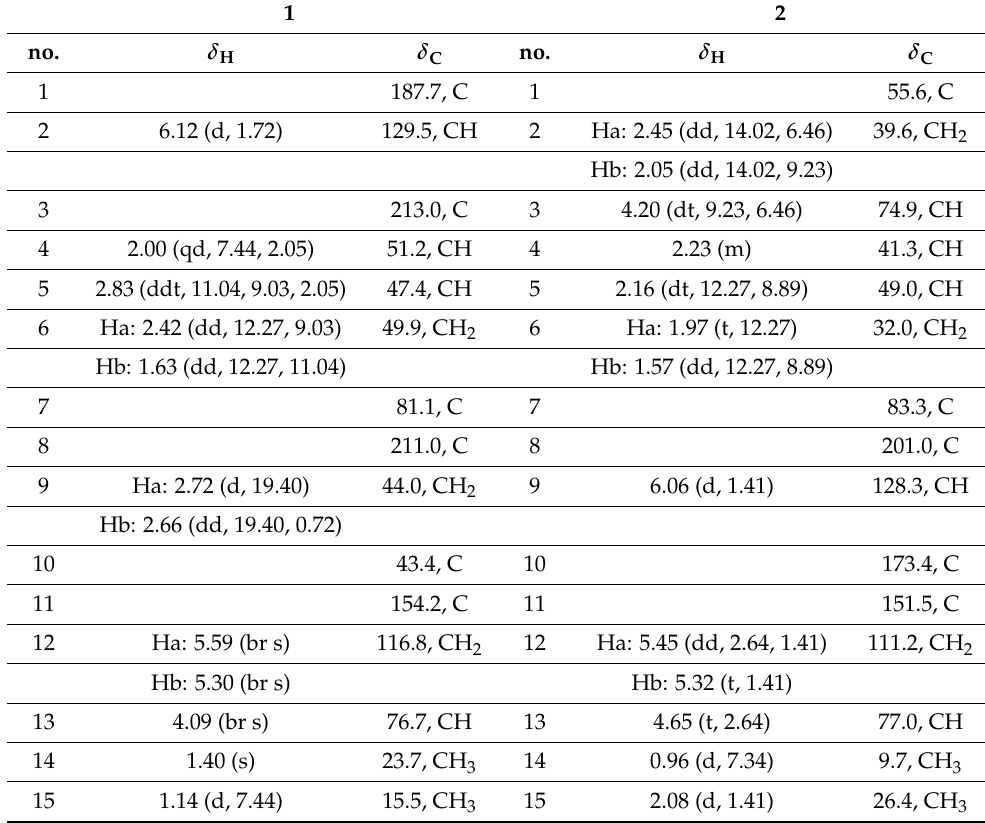
Table 1. 1 H (600 MHz) and 13 C (150 MHz) NMR data of 1 and 2 in